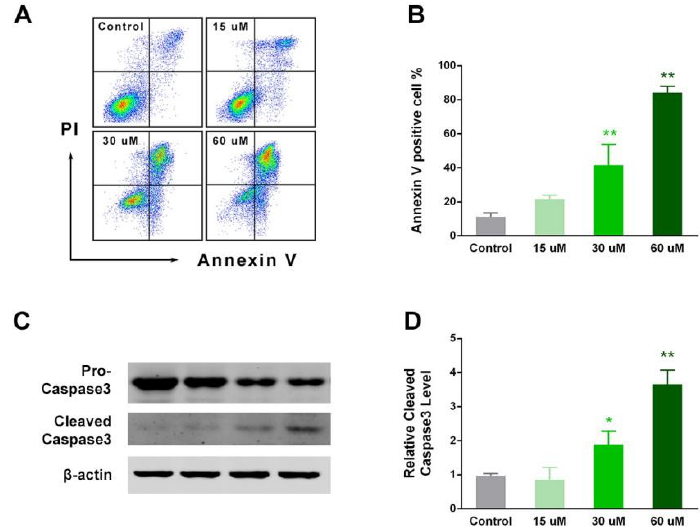
Figure 4. EP enhanced RCC cell apoptosis. ( A ) Typical samples of flow cytometry analysis for Annexin-V and PI-positive cells. ( B ) EP groups had a significantly higher Annexin-V positive ratio compared with the control at 48 h. ( C ) Typical blots of cleaved Caspase-3. ( D ) Cleaved Caspase-3 expression was significantly upregulated in EP groups compared with the control. * p < 0.05; ** p < 0.01, vs. control.